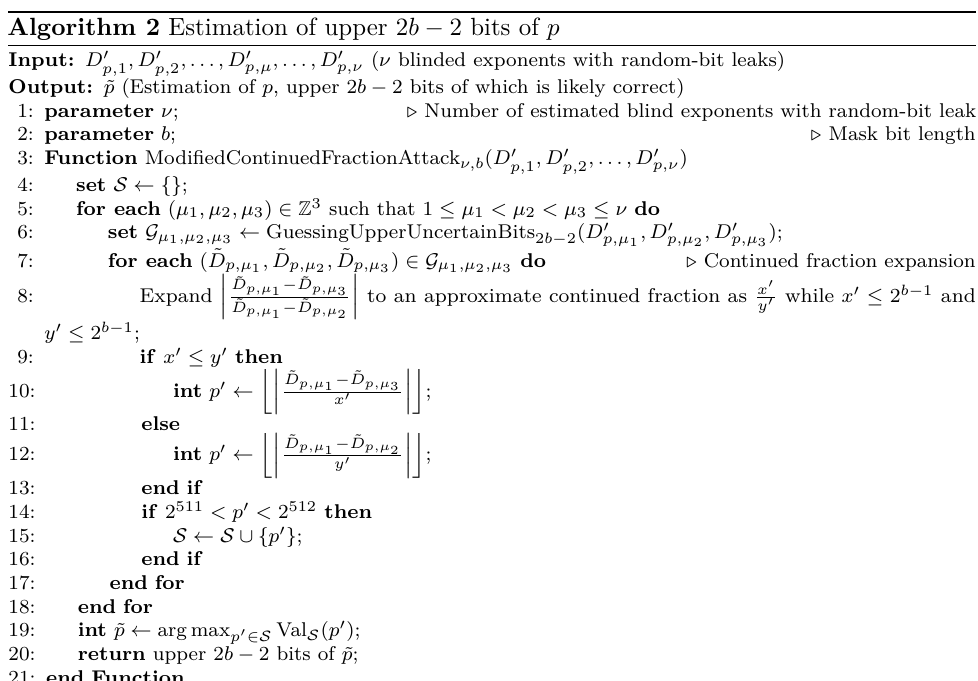
Algorithm 2 Estimation of upper 2 b − 2 bits of